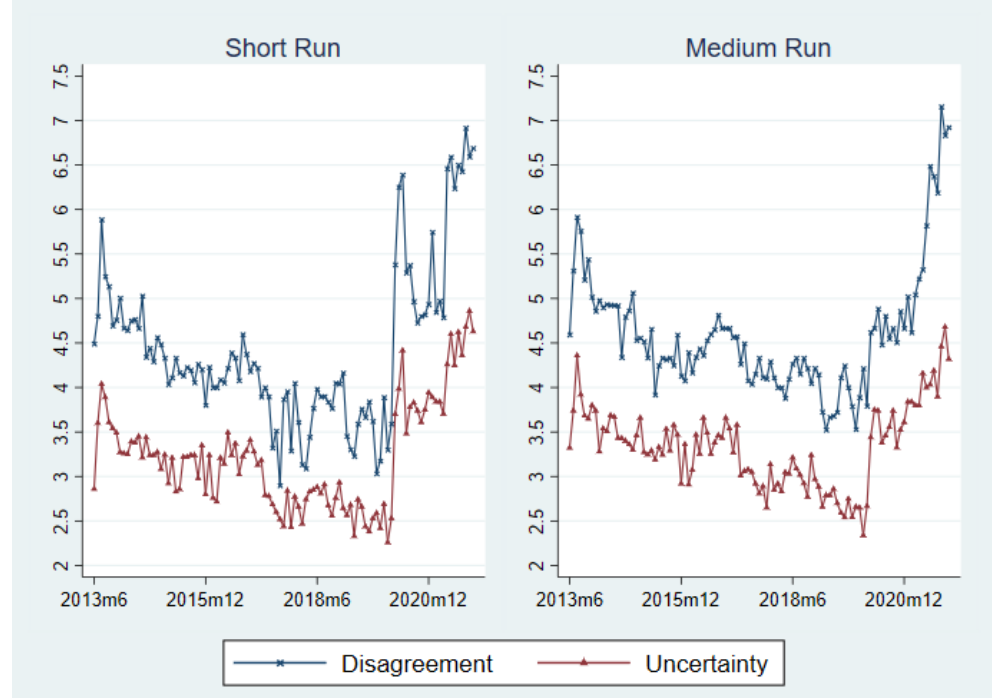
Figure 2. The figure shows measures of cross-sectional disagreement and subjective uncertainty for short run and medium run inflation expectations. The dispersion is calculated as the difference in the interquartile range across the individual implied means in a period. The subjective uncertainty mea- sure is the interpolated median of the interquartile ranges of the individual subjective